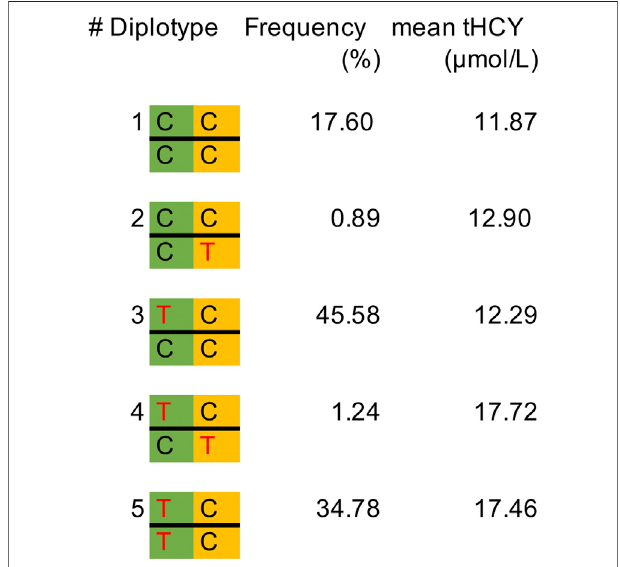
FIGURE 4 | Frequency of diplotypes and the mean tHCY level in the discovery sample. MTHFR C677T is indicated in the green background, and MTHFR C136T is indicated in the orange background. Missense alleles 677T and 136T are indicated in red color. tHCY, total homocysteine.